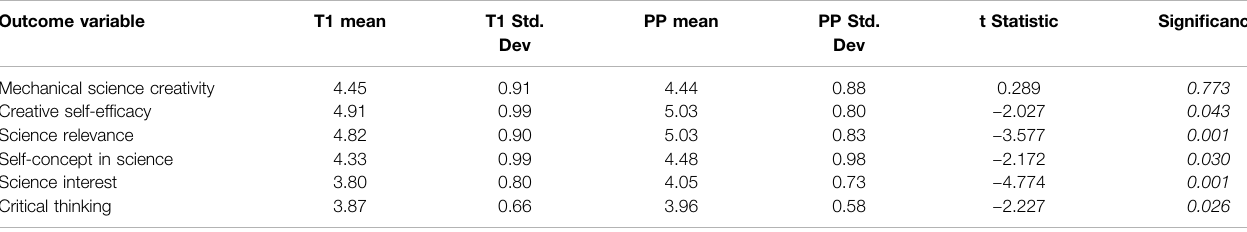
TABLE 3 | Aggregate T1 to past participant outcome variable means independent samples t -Test. Outcome variable